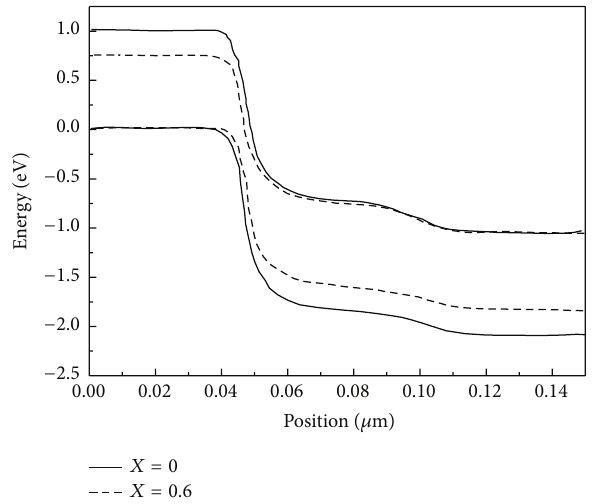
Figure 2: Band diagram profiles along the channel in the on- condition. 𝑉 𝑑𝑠 = 𝑉 𝑔𝑠 = 1